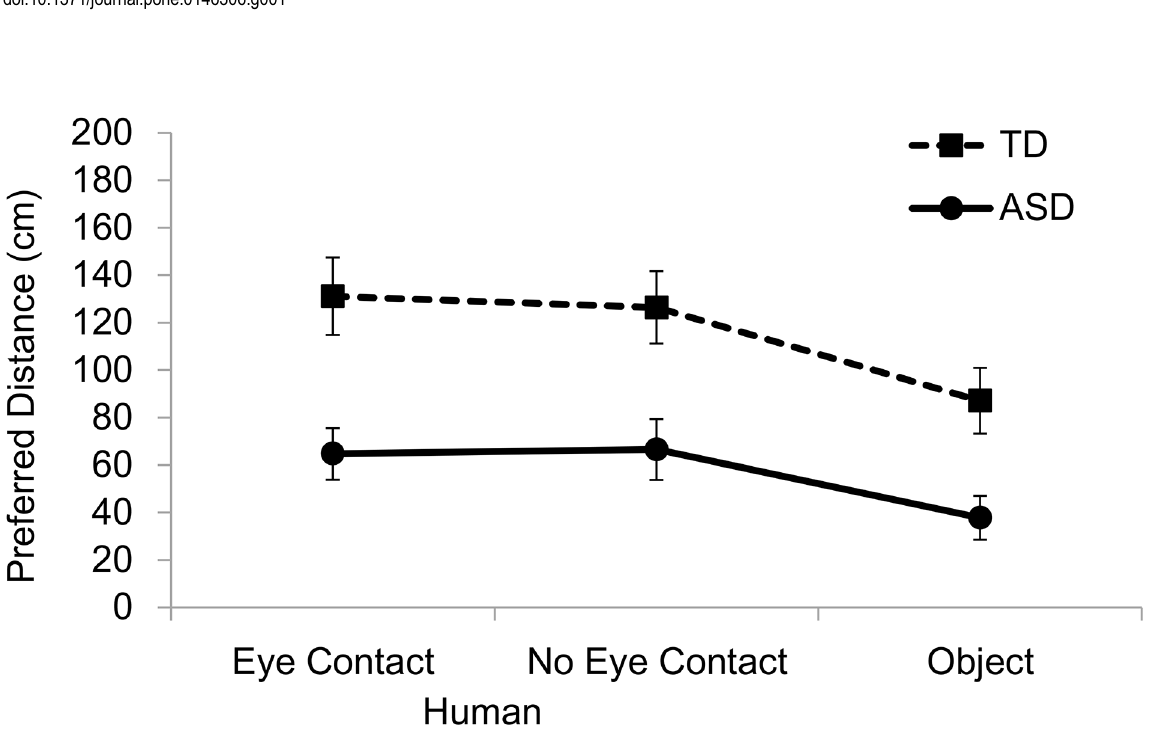
Fig 2. Mean preferred distances from another person and an object when the participants approached. ASD, autism spectrum disorder; TD, typically developing. Error bars indicate standard errors of the mean.